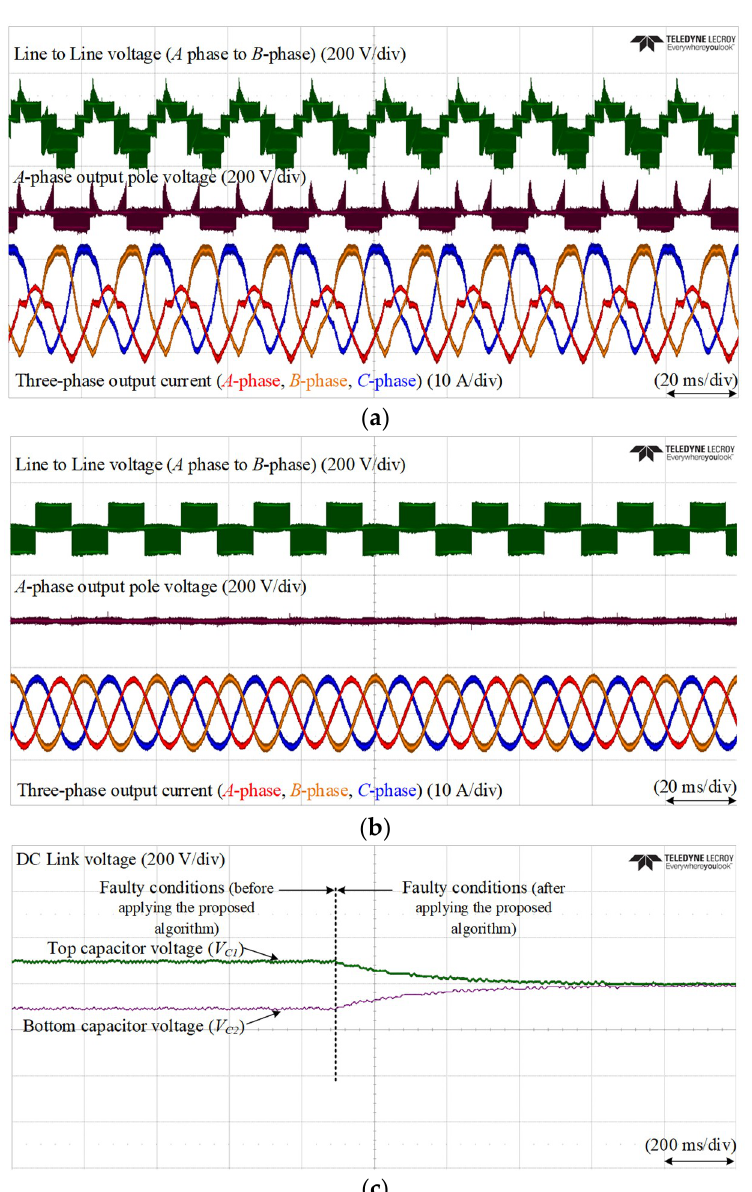
Figure 13. Experimental results for V ab , V an , and three-phase currents when an open-circuit failure occurs at S a / D a1 at ( a ) faulty conditions (before applying the proposed method), ( b ) faulty conditions (after applying the proposed method), and ( c ) top and bottom capacitors voltages before and after applying the proposed method.